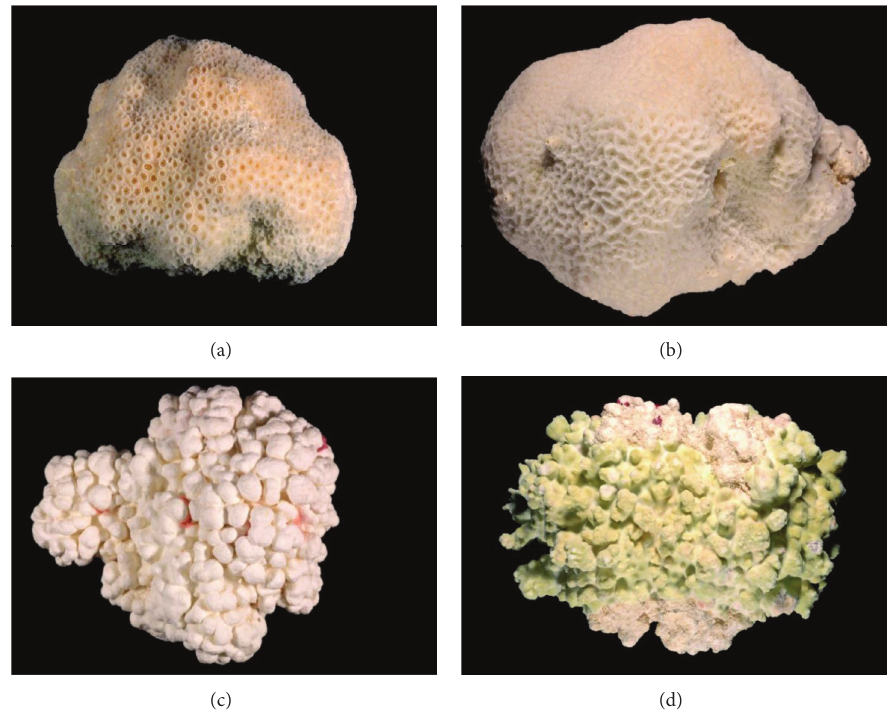
Figure 4: Rolloliths collected from Adele Island. (a) Cyphastrea chalcidicum corallith. (b) Pavona venosa corallith. (c) Red coralline algae rhodolith. (d) Milleporina corallith. Skeletal photos Roger Springthorpe Australian Museum.